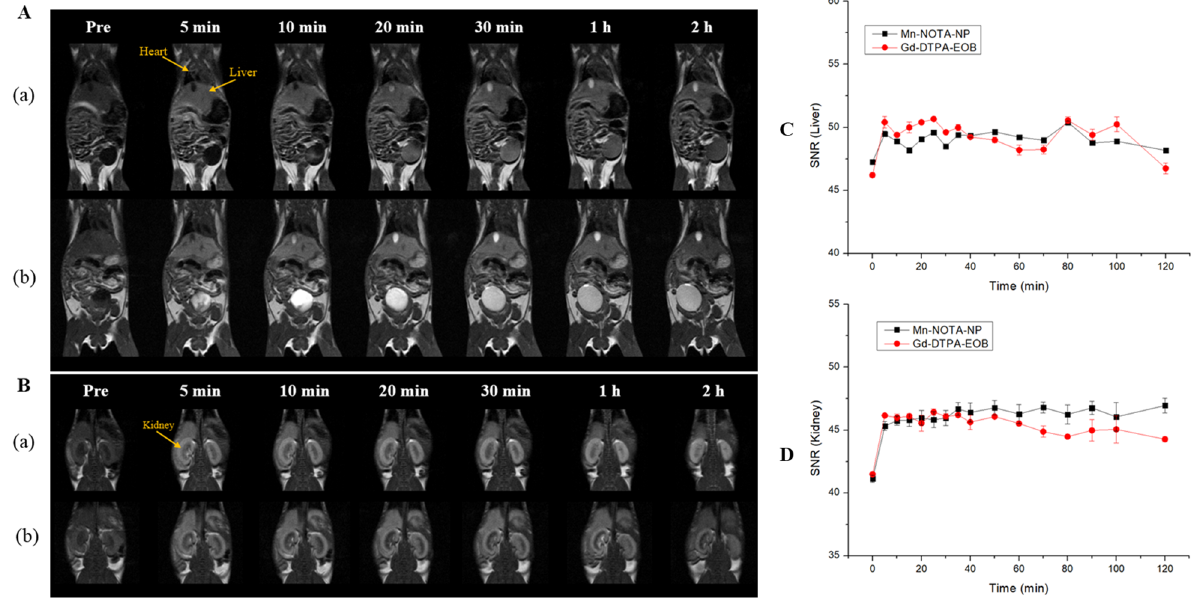
Figure 4. T 1 -weighted images of Balb/c mice recorded at 3.0 T capturing the ( A ) liver and ( B ) kidneys obtained before injection (pre) and at 5, 10, 20, and 30 min and 1 and 2 h after tail vein injection of (a) Mn-NOTA-NP and (b) Gd-DTPA-EOB at a dose of 0.05 and 0.025 mmol/kg, respectively. The graphs depict the signal-to-noise ratio (SNR) profiles of Mn-NOTA-NP (black squares) and Gd-DTPA-EOB (red circles) in the ( C ) liver and ( D ) kidneys after injection. Data are presented as mean ± SD and n = 3.